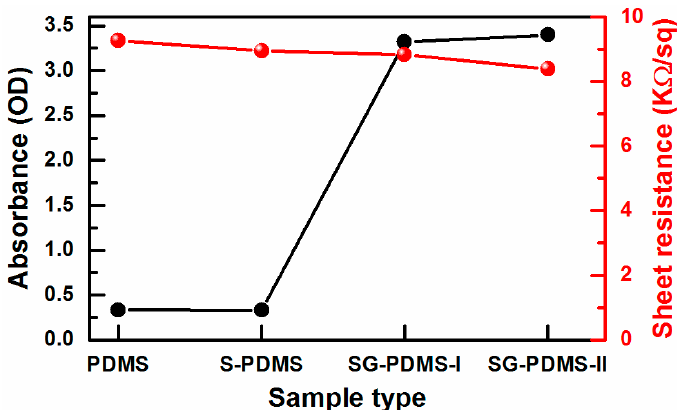
Figure 4. Absorbance (at 500 nm) and sheet resistance of the GNP-PDMS@[PVA / GNP-PSS] 3 composite TENGs. For simplicity, only the GNP-PDMS sample labels are displayed in the x-axis.